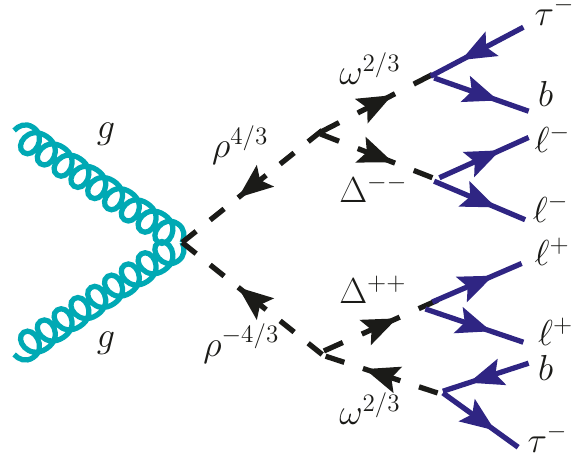
Figure 11 . Feynman diagram for the pair-production of the ρ 4 / 3 component of the S 3 LQ ( pp → ρ 4 / 3 ρ − 4 / 3 ), followed by ρ decay to the ω 2 / 3 component of the R 2 LQ and the doubly-charged component of the ∆ quadruplet ( ρ ∓ 4 / 3 → ω ± 2 / 3 ∆ ∓∓ ). The ω 2 / 3 component can then decay to